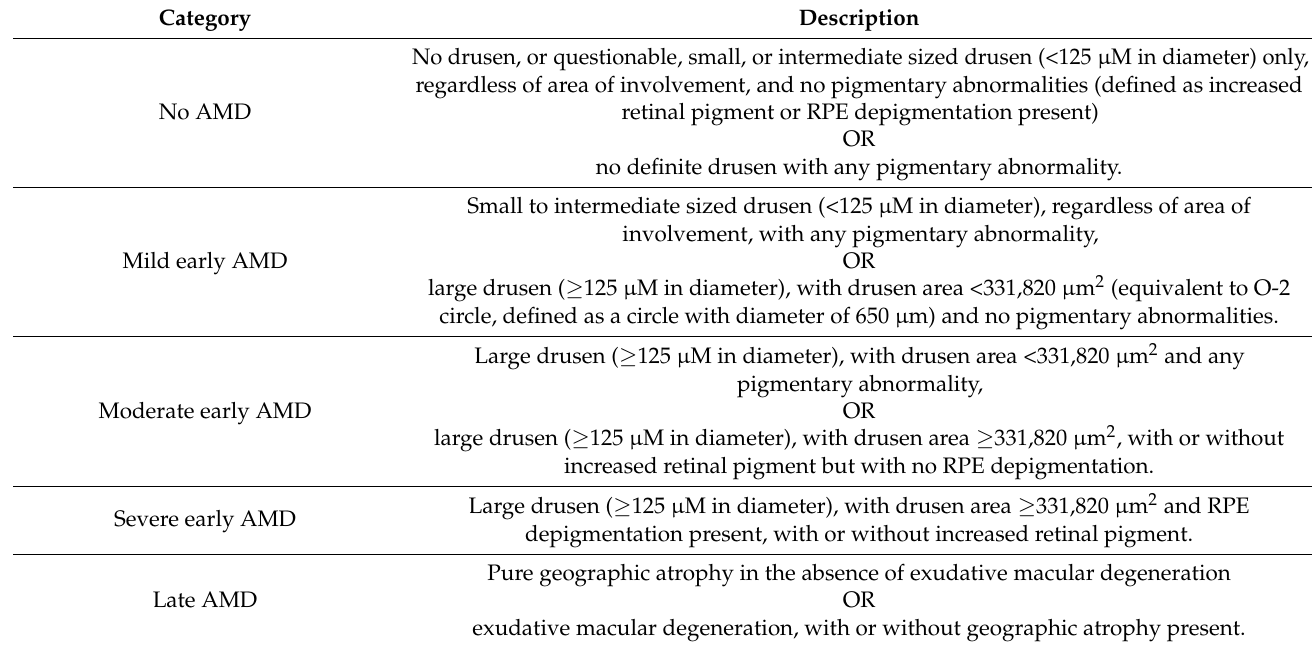
Table 2. The stage classification of age-related macular degeneration (AMD) depending on the drusen size and distribution area (from Klein 2014